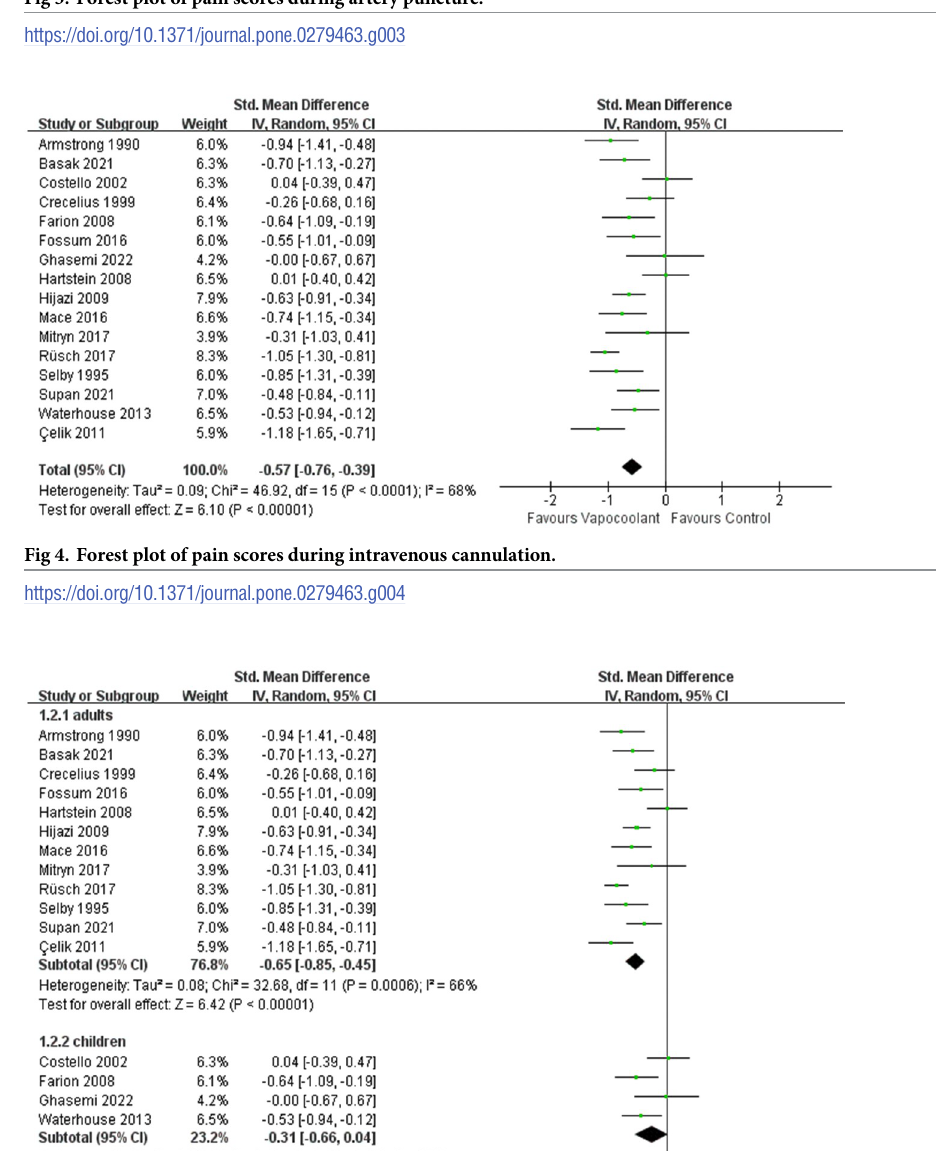
PLOS ONE | https://doi.org/10.1371/journal.pone.0279463 February 13,